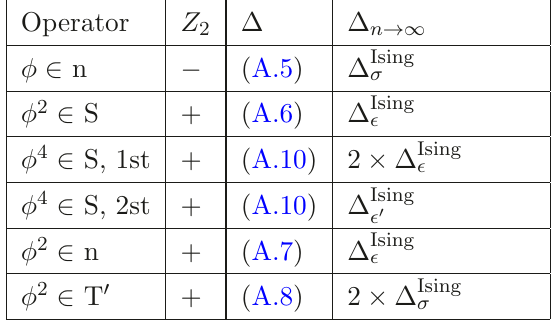
Table 2 . Scaling dimensions of low-lying operators at the fixed point P 2